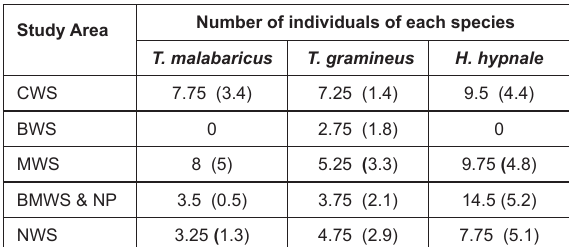
Table 3. Observation of pit vipers in different study sites